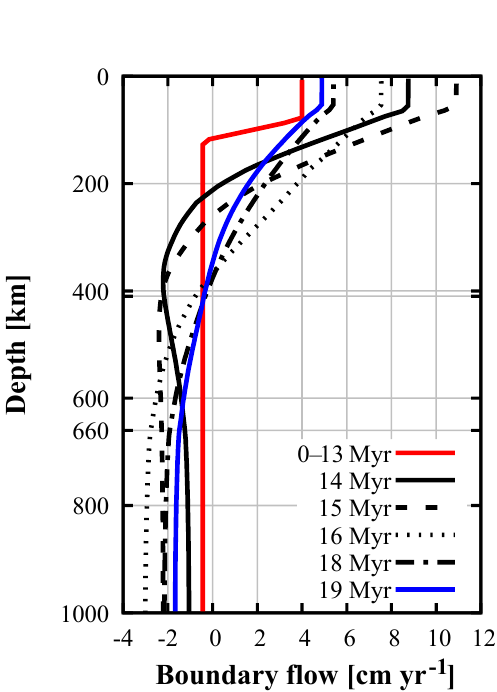
Figure B3. Left boundary in- and outflow for the compressible sub- duction model. In red the velocity profile that is prescribed for the first 13Myr. In black are the velocity profiles obtained with open boundary conditions. Positive values represent inflow and negative